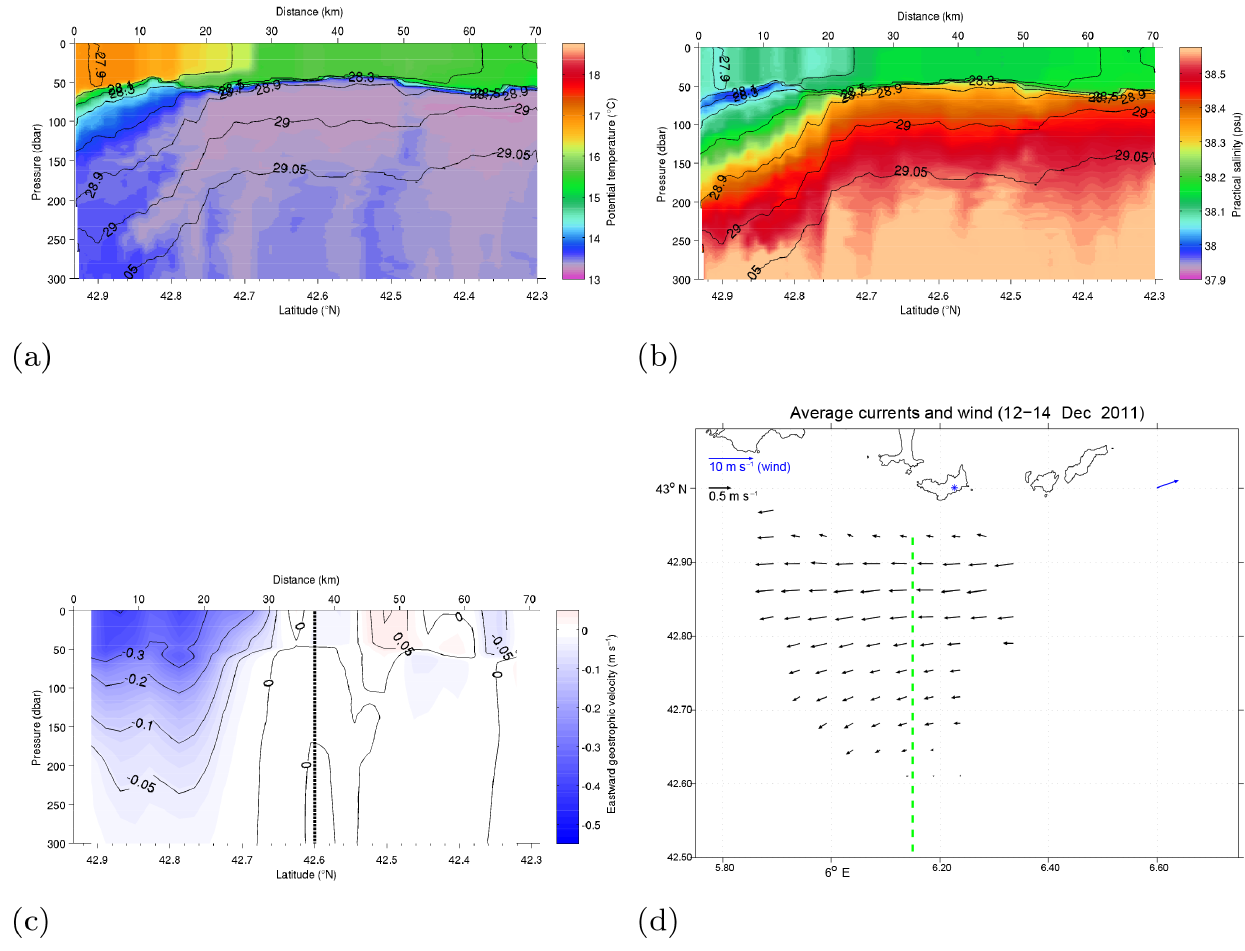
Figure 5. Potential temperature (a) , salinity (b) , and geostrophic velocity (c) for glider Transect 5 (see also Table 1 for time period definition). Potential density anomaly isolines (black) are in panels (a) and (b) . The black dashed line (c) represents the southern boundary of the HF radar field. In panel (d) , black arrows show the surface currents from HFR averaged during the period in which the glider transect (green dashed line) falls inside the HFR coverage (and considering only grid points with at least 80% available data over the time period). The blue arrow represents the wind from Porquerolles station averaged over the same period considered for the HFR